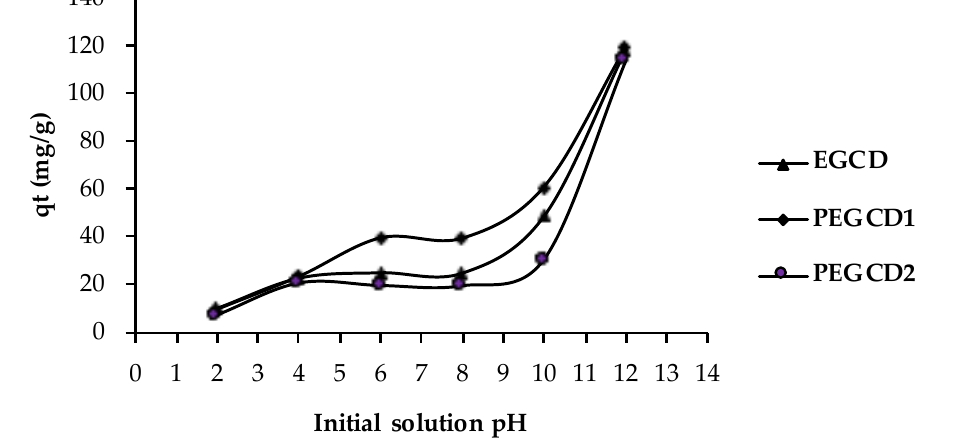
Figure 6. Effect of initial pH solution on the adsorption capacity of MB by EGCD, PEGCD1 and PEGCD2.